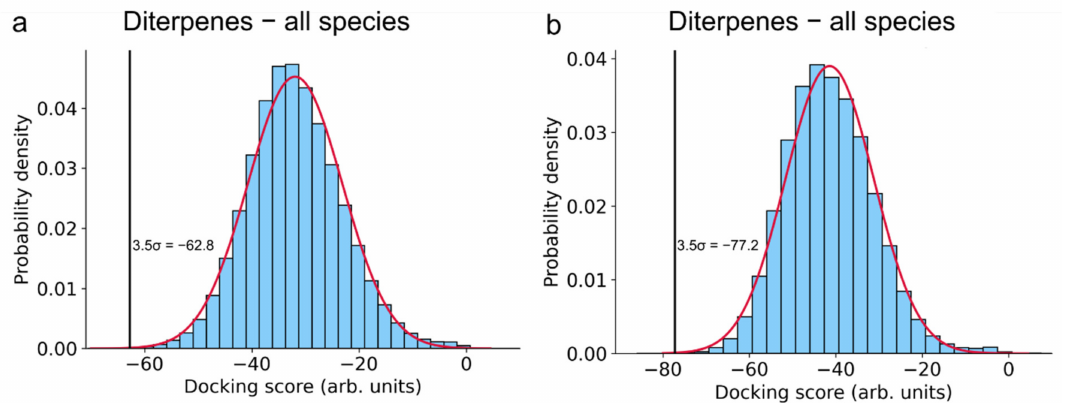
Figure 2. Normal distribution fit of the inverse docking scores. ( a ) Combined distribution of docking scores obtained by inversely docking the rosemary diterpenes carnosic acid, carnosol, and rosmanol to the whole ProBiS-Dock Database. ( b ) Distribution of docking scores for rosmarinic acid. A cut-off criterion of 3.5 σ was used to select the most promising protein–ligand complexes to be further investigated in more